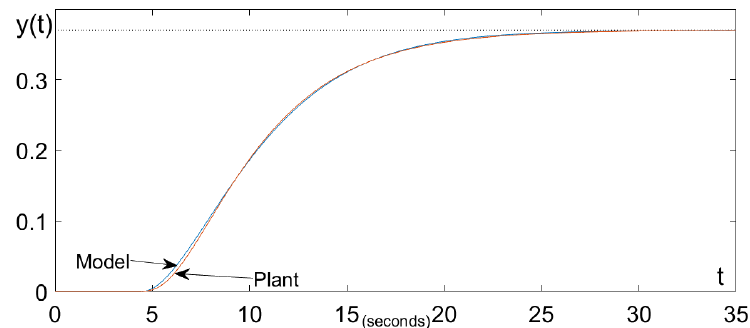
Figure 5. Step responses of the plant from example 3 and its model.